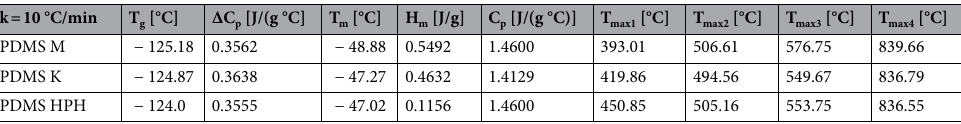
Table 1. Summary of typical thermal properties values coming from DSC and TGA measurements for samples produced via different routes. The speed of heat remained constant: 10 °C/min. C p was measured in quasi-isothermal mode during MT-DSC scan. T g glass transition, ΔC p heat capacity change, T m melting temperature, H m melting enthalpy, C p heat capacity, T max1-4 decomposition